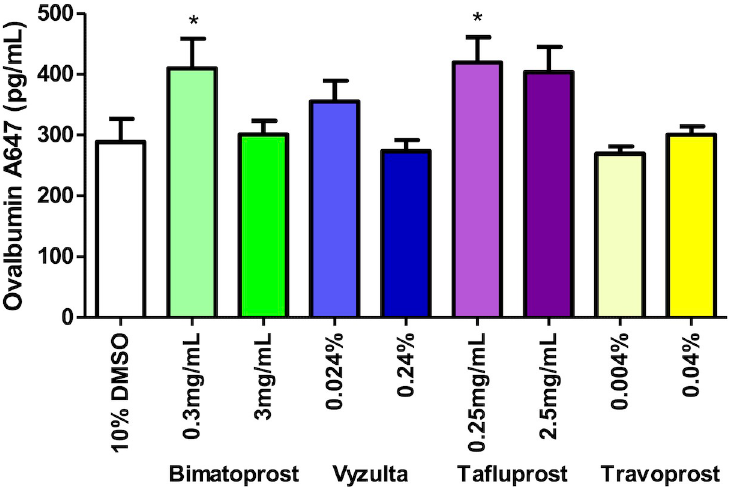
Fig 2. Fluorometric analysis of nasal turbinate homogenates after prostaglandin F2alpha agonist bimatoprost, latanoprostene bunod, tafluprost, and travoprost inhalation and ventricular tracer injection. Slightly enhanced tracer recovery relative to controls was seen with the lower doses of bimatoprost and tafluprost. Error bars denote SEM. Asterisks indicate p < 0.05 relative to controls.